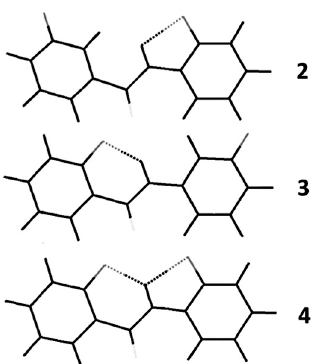
Figure 7. Optimized structures of fluorinated benzanilides visualized using Molden-4.7: HB parameters were measured by their optimization (Molden Control) in the vicinity of F ··· H-N HB distances and angles.